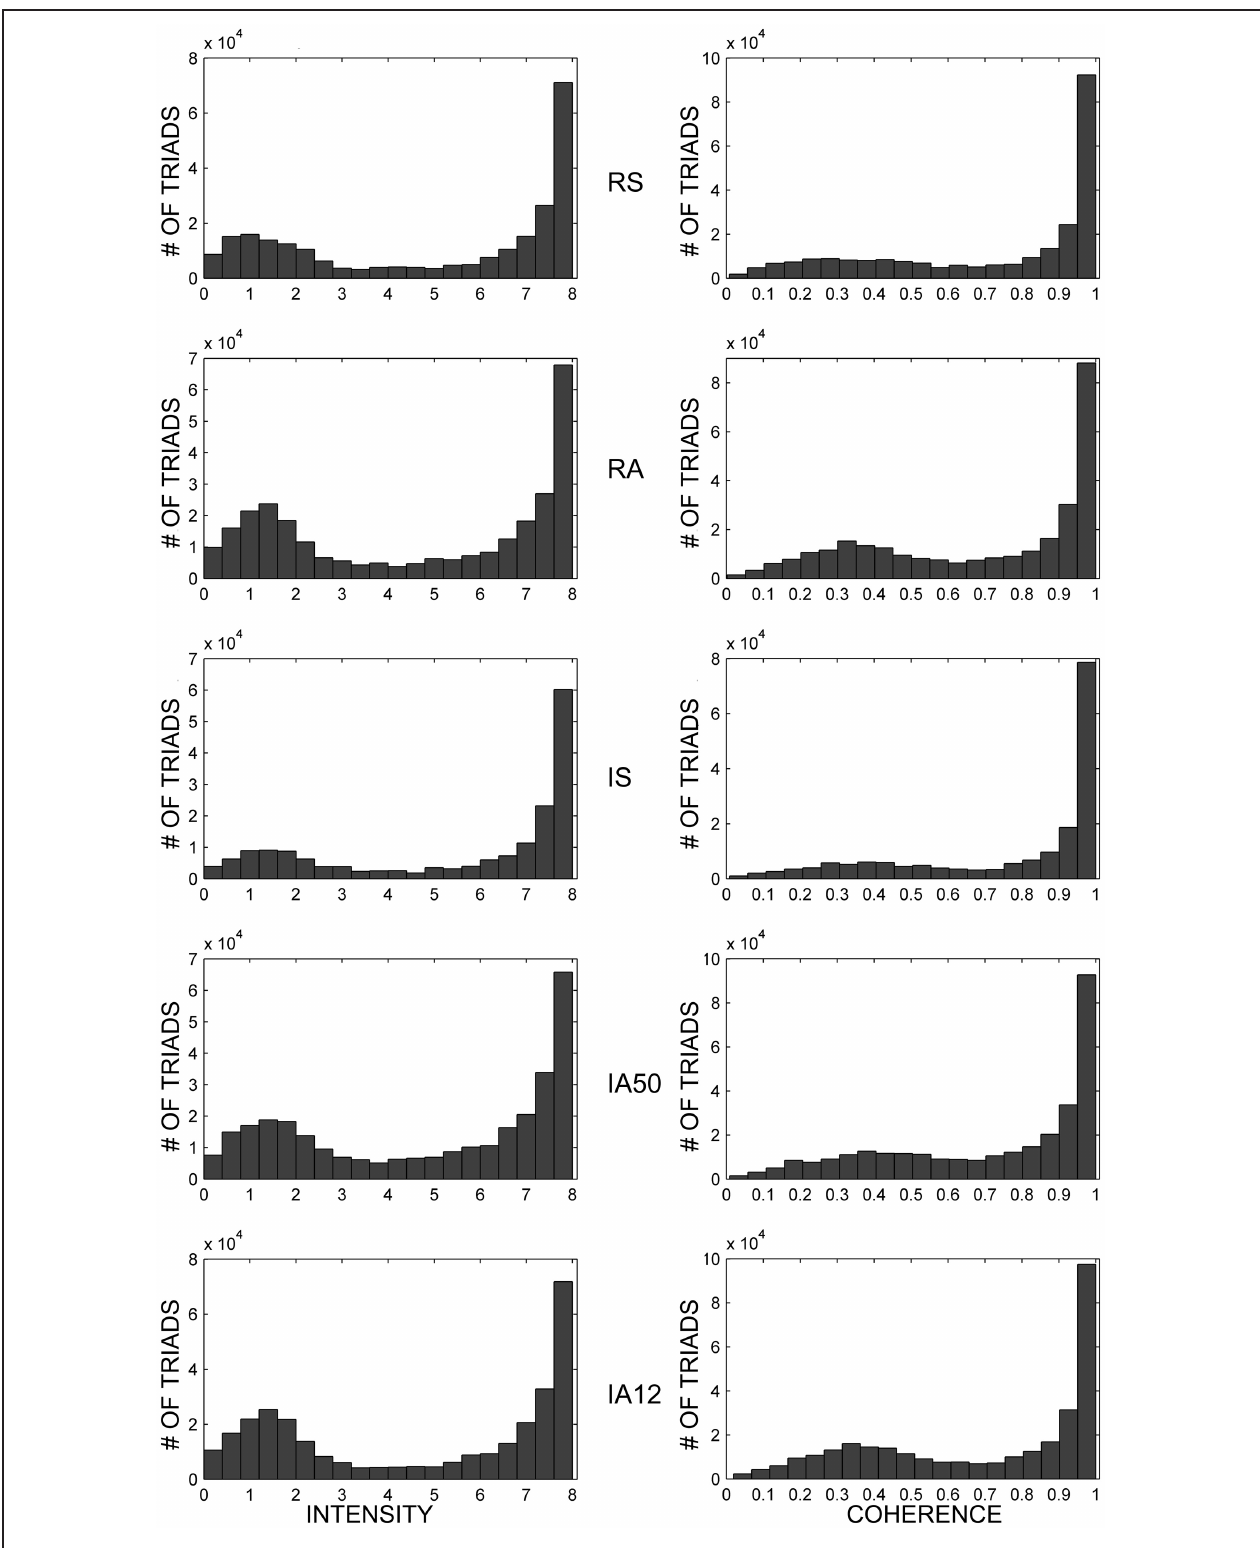
FIGURE 6 | Dynamic triad intensities and coherences. Exemplar dynamic triad intensity (left) and coherence (right) distributions in response to separate external input regimes. All examples are from the same initial